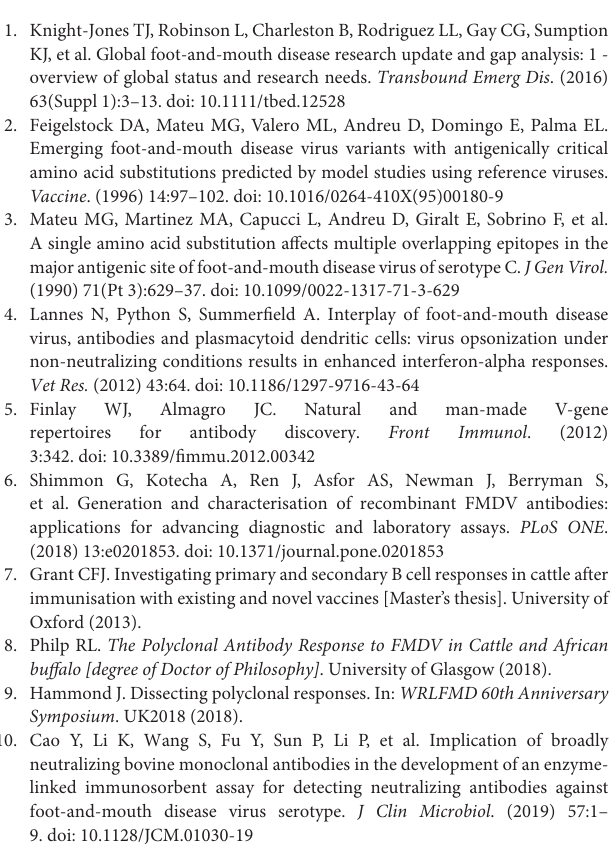
subtle perturbations cycles. The graphics are based on water-refined models generated by HADDOCK. The clusters (indicated in color in the graphs) are calculated based on the interface-ligand RMSDs assessed by HADDOCK, with the interface defined automatically according to all observed contacts. The various FCC, i-RMSD, and l-RMSD structural analyses are made with the best HADDOCK model (the one with the lowest HADDOCK score). Interface-RMSD (i-RMSD) calculated on the backbone (CA, C, N, O, P) atoms of all residues involved in intermolecular contact using a 10Å cutoff. Ligand-RMSD (l-RMSD) calculated on the backbone atoms (CA, C, N, O, P) of all (N > 1) molecules after fitting on the backbone atoms of the first (N = 1) molecule. The average values are calculated on the best 4 structures of each cluster (based on the HADDOCK score). Cluster averages and standard deviations are indicated by colored dots with associated error bars. Supplementary Figure 5 | Quality scores for Ab molecular models. The scoring, according to MolProbity, includes three metrics (cells in blue) with values that improve according to a scale of colors from red to green. The tables reflect data from 3 models for each of the mAbs 4A2 and 1E12, as well as data for the reference mAb 4C4. Supplementary Figure 6 | Multiple sequence alignment for anti-A24 cruzeiro FMDV mAbs. H-chain aa. sequence alignment between 4A2 mAb (seq. A41-HL) and 2 mAbs developed (F24G3 and G1) against the same FMDV strain. The red boxes indicate CDR1 regions. Supplementary Table 1 | List of mutant peptides. Mutations and RGD motifs are bold-highlighted. ( ∗ )Leu aa usage to contrast the Arg aa prevalence. ( ∗∗ )Pro and Tyr aa usage as chemical structure modifiers for the RGD + 1 + 4 short helix